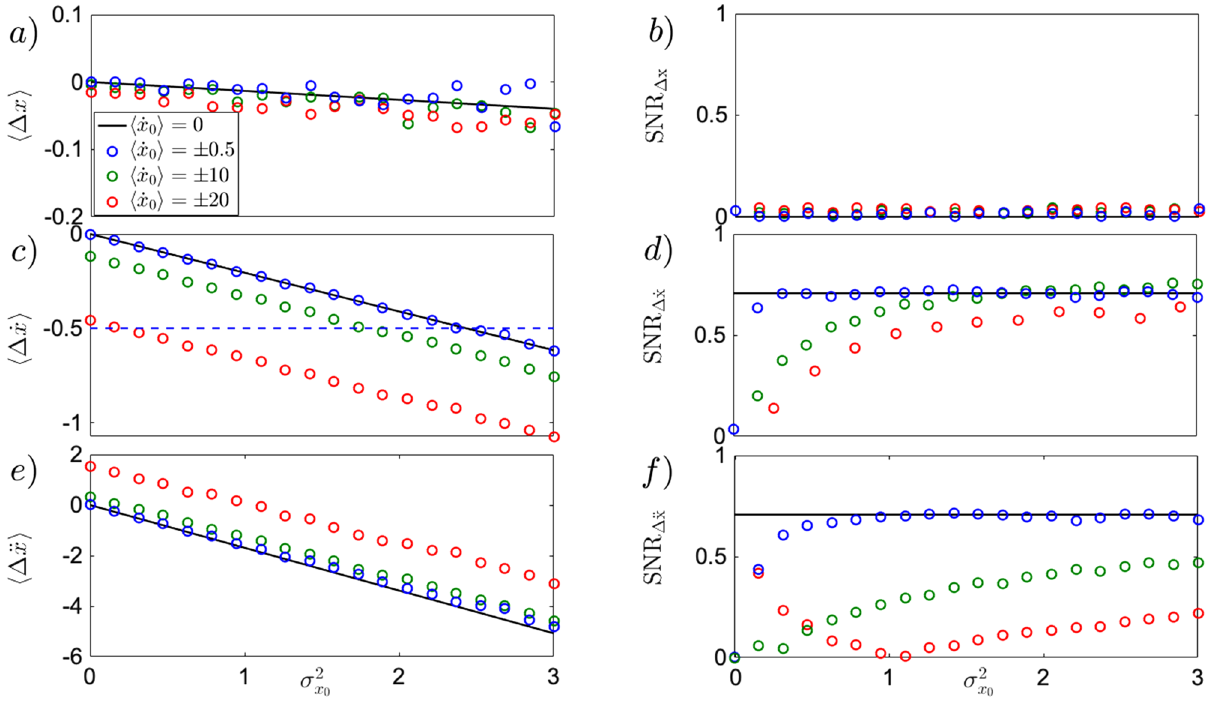
Figure 3. Uncertainty-induced effects for initially moving particle in position statistics (a,b) , instantaneous velocity statistics (c,d) , and instantaneous acceleration statistics (e,f) . All simulations (dots) have been 0 . For mean particle position (a) the dynamics remains unchanged performed based on Eq. (1) using σ 2 x 0 = x ˙ from that of Eq. (11) (black line) independent of the chosen initial velocity 0 � , while the SNR (cid:31) x ( b , dots) �˙ remains small (close to zero), as the standard deviation increases faster than the mean. For mean instantaneous velocity ( c,d ), the approximation introduced in Eq. (12) (black line) holds true for values of initial velocity > 0 ) and stochastic breaking (for < 0 ) x 0 x 0 x 0 5 . Within this frame, stochastic speeding (for up to �˙ � = ± �˙ � �˙ � (cid:31) x x 0 x 0 0.5 (blue dots), the initial position uncertainty are witnessed when . Specifically, for � ˙ � = −|�˙ �| �˙ � = ± (cid:31) > 5 x x 0 0.5 (blue dashed line). For values induced stochastic speeding/breaking is met at values of � ˙ � = − |�˙ �| (green, and red dots) the dynamics can no longer be described by Eq. (12), as higher order nonlinear terms become relevant. As a result, the slope remains similar to that of the black line, but the curve is shifted to a non- 0 . The resulting SNR (cid:31) zero value at σ 2 x x display a slower convergence to the black line as the initial velocity 0 = ˙ becomes larger in magnitude. Particle acceleration ( e,f ) displays a solid robustness against the initial velocity < 20 in both mean ( e ), and SNR (cid:31) x 0 x ( f ). However, for values of �˙ x 0 � ≥ 20 (red dots), the evolution of mean �˙ � ¨ x (cid:31) instantaneous acceleration deviates from the approximation of Eq. (13) (black line). In this regime, the � ¨ � SNR (cid:31) x presents an initial decrease, index of highly unstable dynamics, followed by a slow convergence towards ¨ 6 k B T µ m − 3 Kg − 1 , T 300 K, Ŵ 10 − 2 Hz, t 0.1 ms, the black line. Eq. (1) has been simulated using κ = = = = dt 2 10 − 5 ms. 10 4 trajectories where generated with 5000 samples = ×